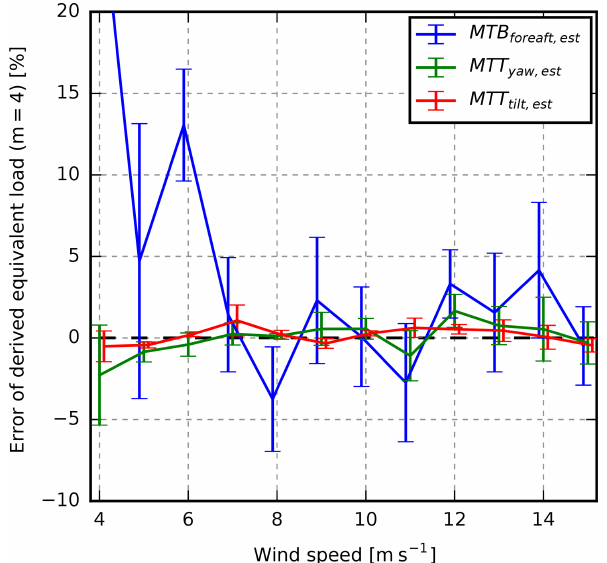
Figure 6. Relative fatigue load error of the derived tower-load sen- sors compared to the HAWC2 simulated tower loads. The derived tower-load sensors are obtained from the HAWC2 simulated blade- root load sensors and calibrated using wind-speed-dependent cali- bration